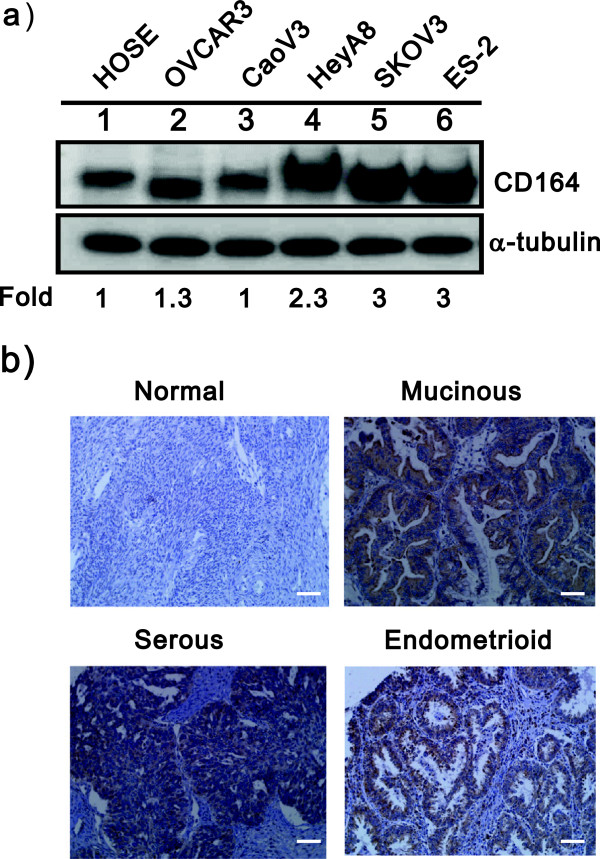
Quantification of the expression of CD164 in ovarian cancer cell lines and an ovarian tissue array. a) Cell lysates from indicated ovarian cells were subjected to immunoblot analysis with an antibody against CD164 protein. α-tubulin was used as a loading control. b) Immunohistochemical staining of malignant and normal ovarian tissue section stained with rabbit anti-CD164 antibodies and CD164 levels in representative ovarian tumor tissue. Scale bars = 50 μm.